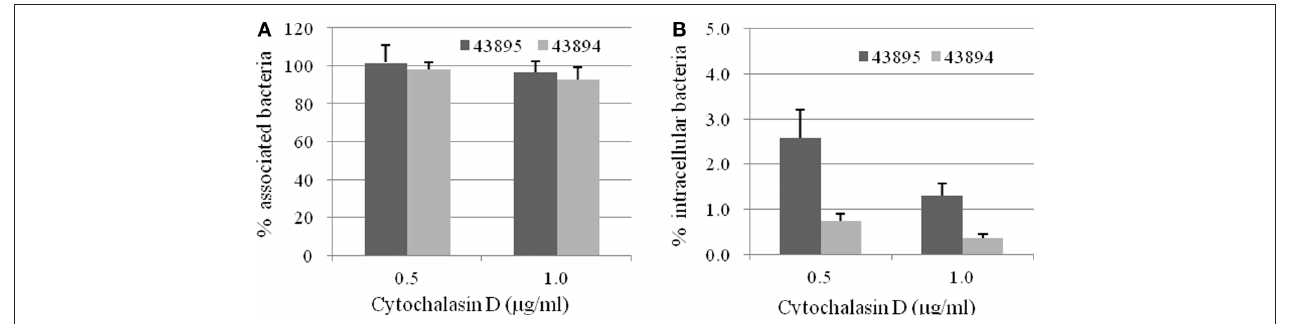
FigUrE 5 | Effect of cytochalasin D on E. coli O157:H7 association with and internalization by the PBrE cells. The PBRE cell monolayers were pretreated with cytochalasin D for 30 min before the addition of E. coli O157:H7 at 100 MOI and incubated for 4 h in the presence of the inhibitor. (A) Total cell-associated bacteria